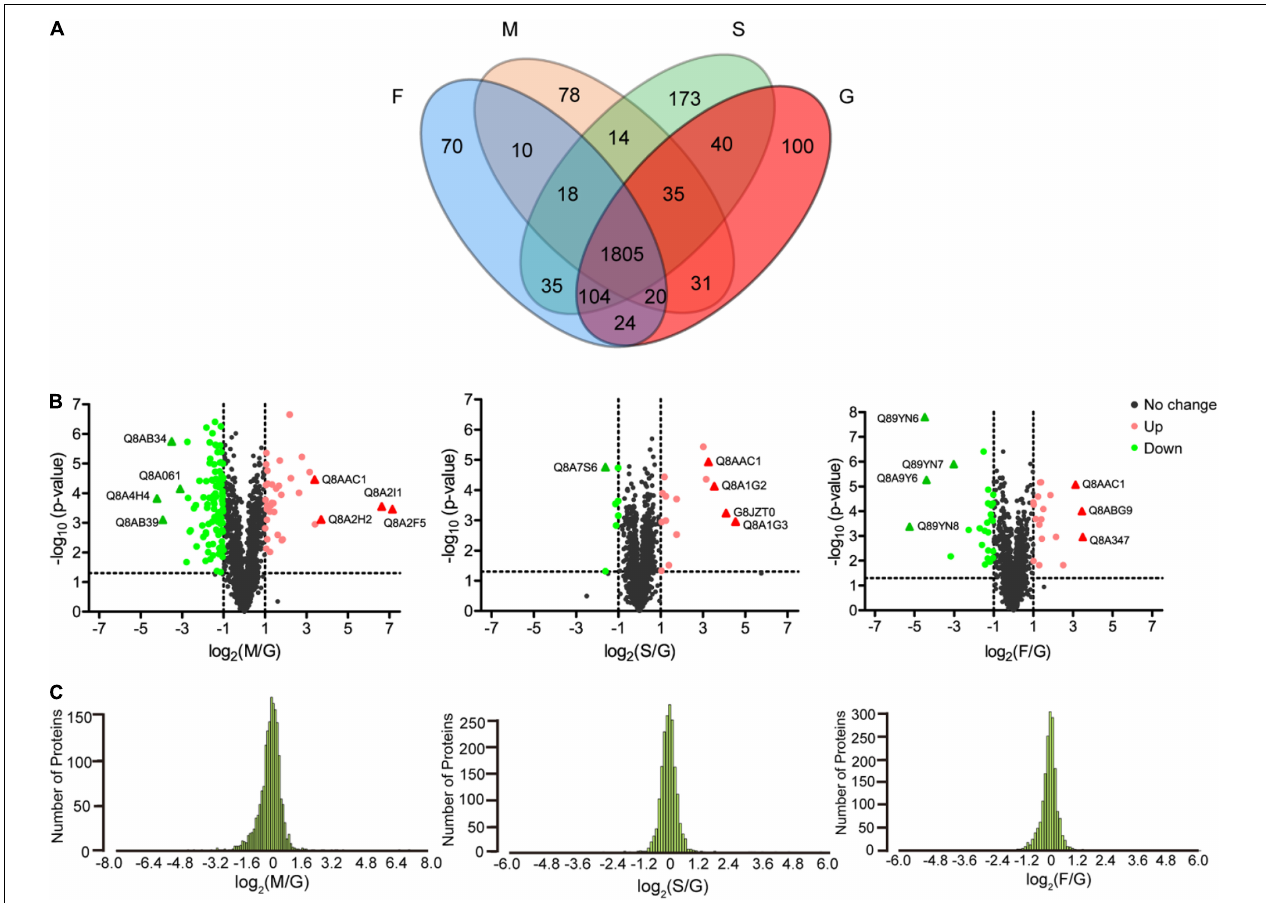
FIGURE 5 | Analysis of differentially expressed FGPs in different comparisons. (A) Venn diagram of differentially expressed FGPs of B. thetaiotaomicron under four carbohydrate nutrition conditions. (B) Volcano plots depicting the enrichment (x axis) and significance (y axis) of the identified FGPs for mucin/glucose (left), starch/glucose (middle), and fucoidan/glucose (right). (C) Normal distribution of differentially expressed FGPs for mucin/glucose (left), starch/glucose (middle), and fucoidan/glucose